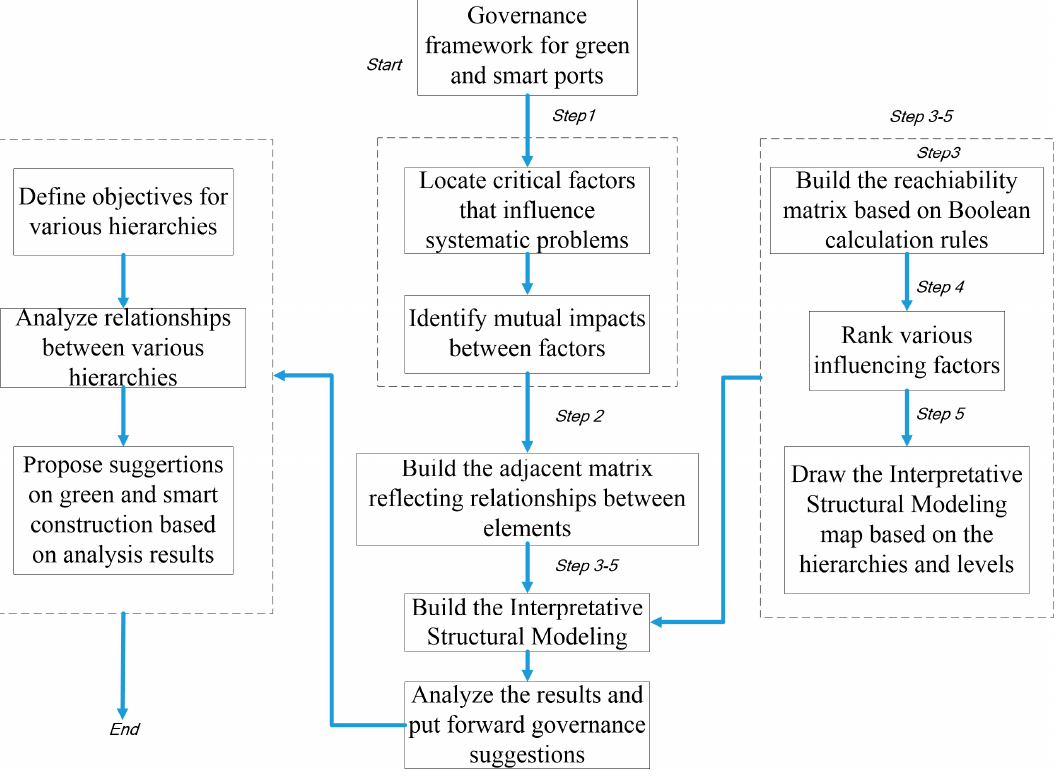
Figure 2. Steps to build a governance framework for a green and smart port.